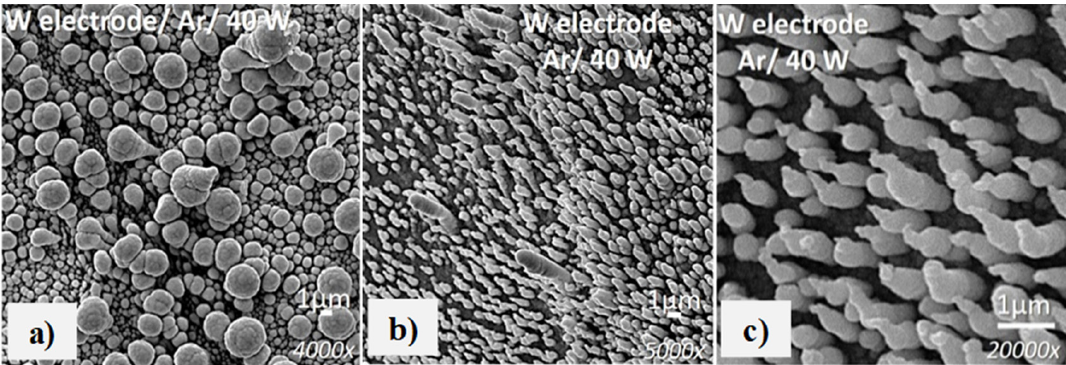
Figure 10. Margin zone_SEM images of W surface electrodes exposed to Ar-MD: ( a ) combinations between cauliflower and solidified droplets shapes, ( b ) columns structures and ( c ) nano-cone structures.